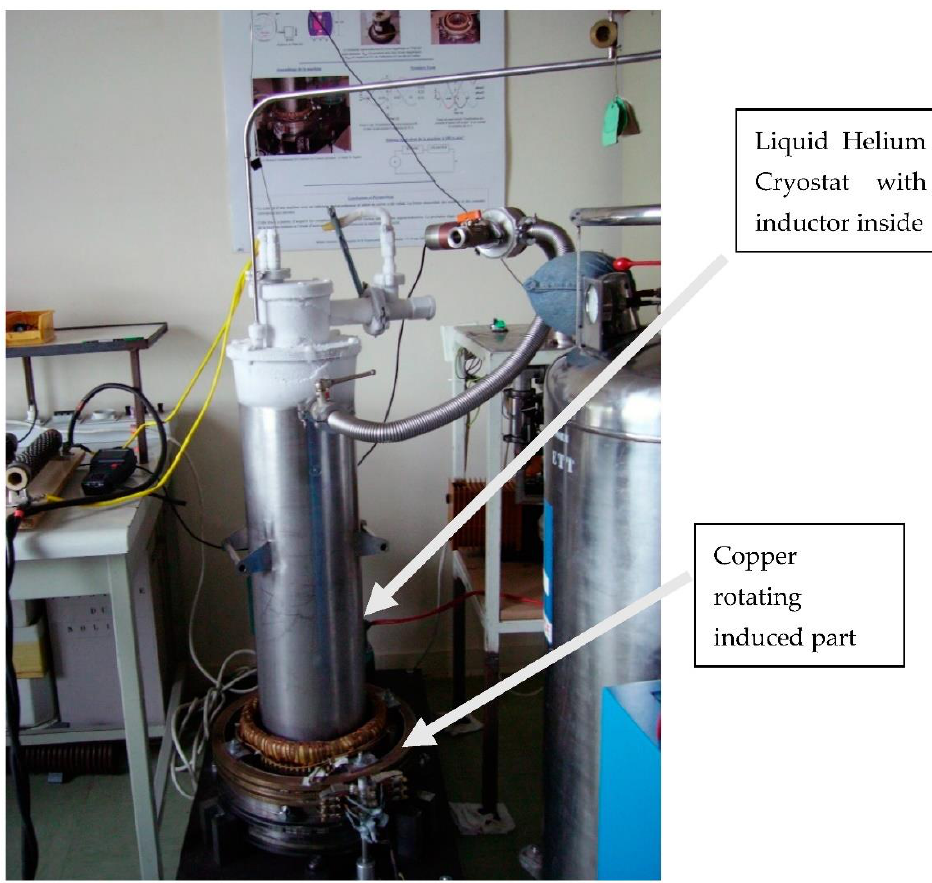
Figure 3. HTS bulk magnetic flux concentration inductor motor.